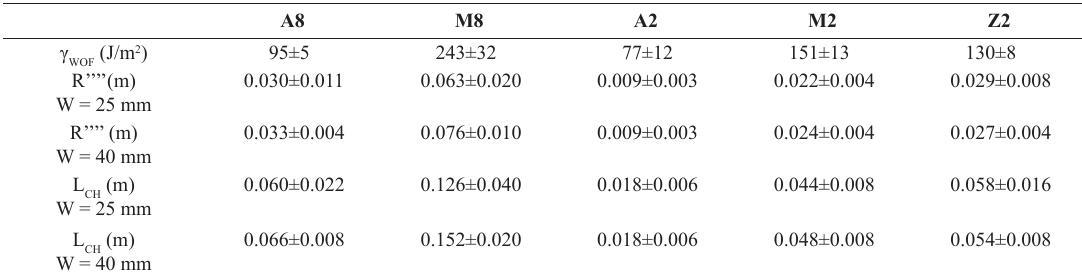
Table 4. γ , R’’’’ and L of bar-like samples, considering the two values of W for all WOF CH